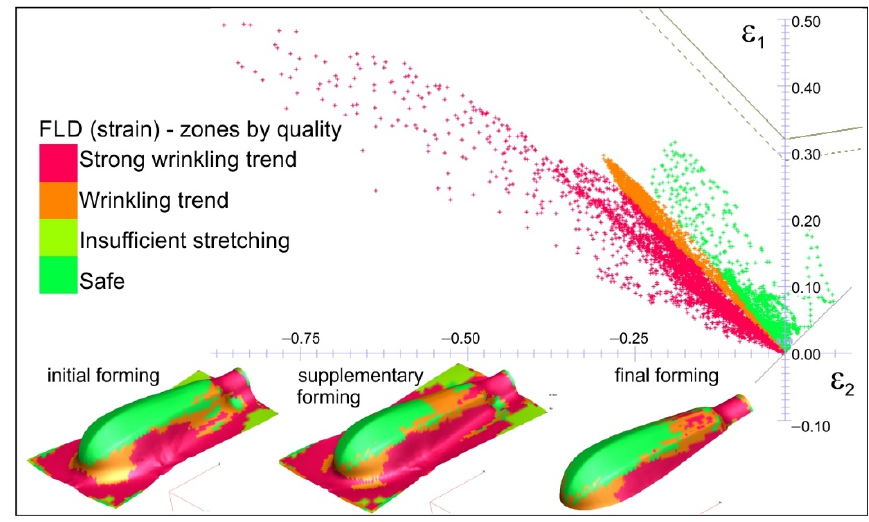
Figure 8. Strain distribution (zones by quality) in comparison with forming limit diagram.